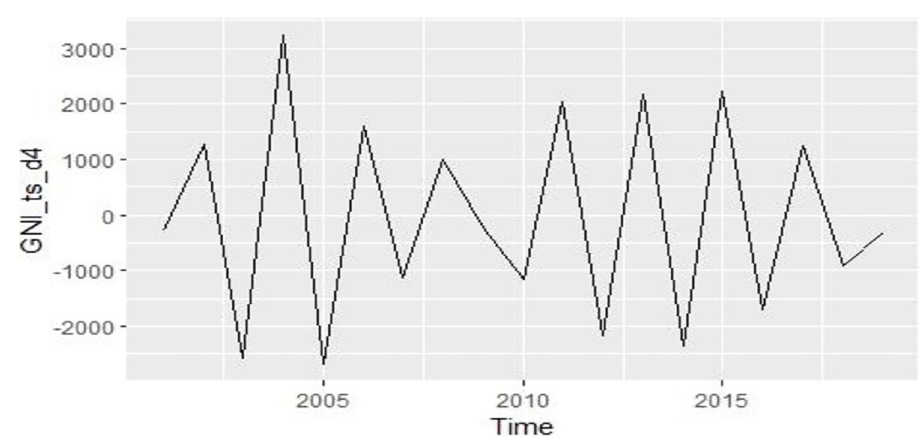
Fig 5. Fourth difference time series plot of GNI.